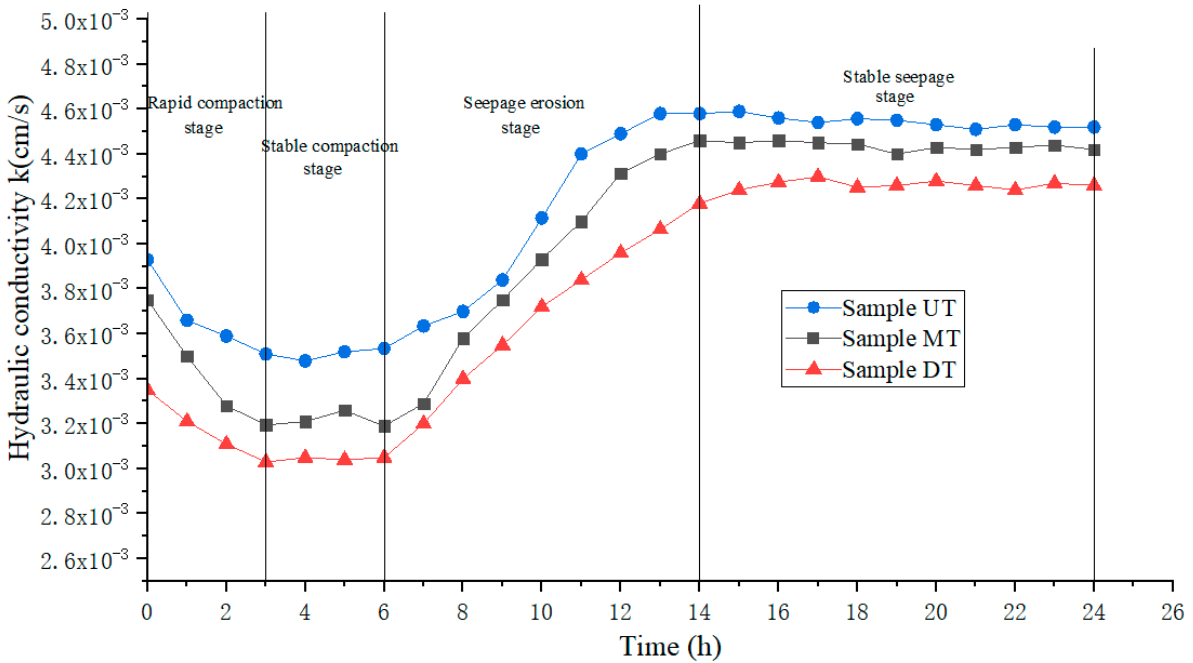
Figure 8. Changes in hydraulic conductivity with time under unsteady seepage.